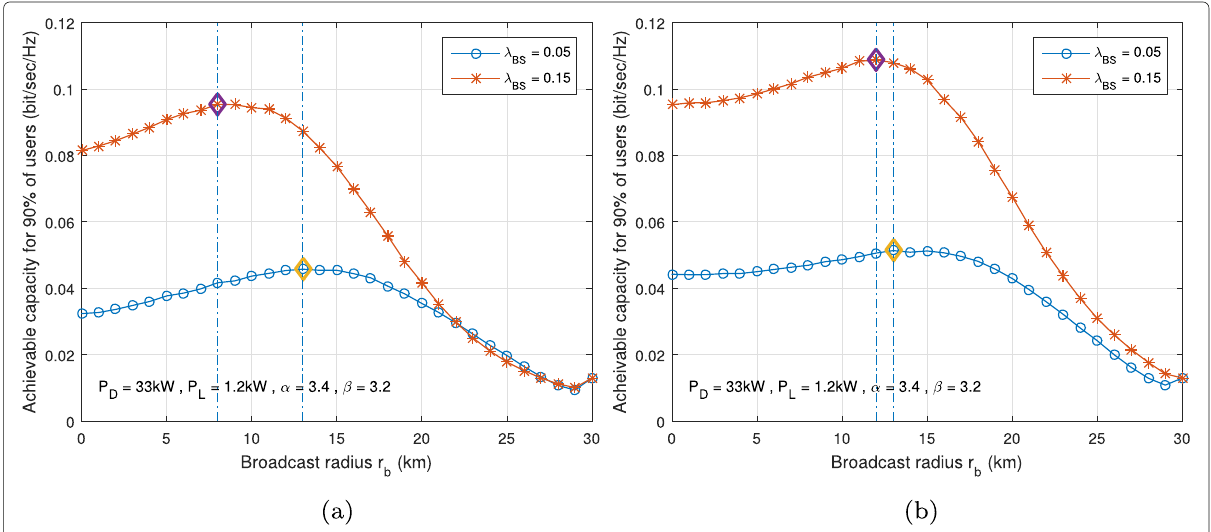
Fig. 10 Achievable user capacity per unit frequency vs. the BC radius r b for − 105 dBm noise power and T = 0 dB. a Shared spectrum scenario b Dedicated spectra